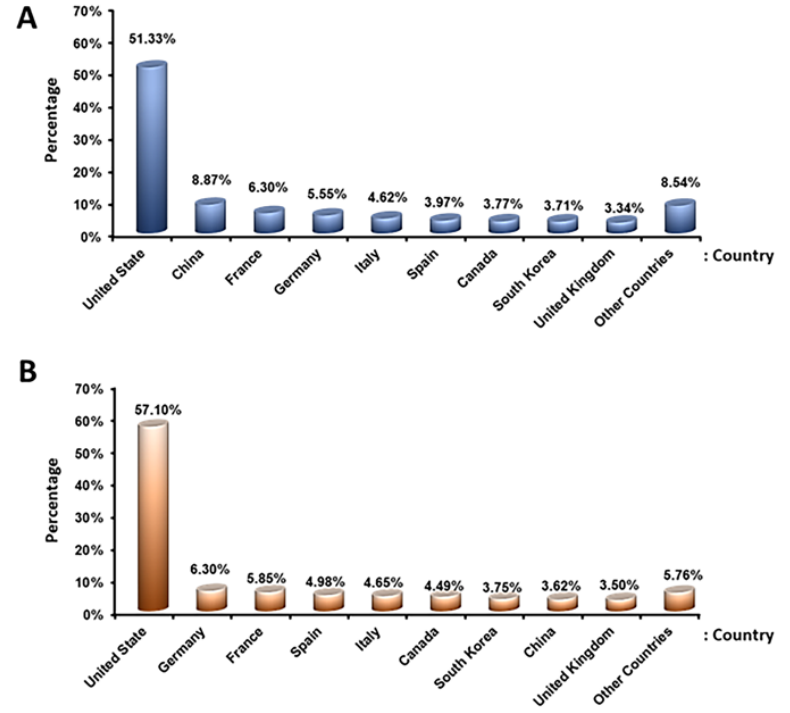
Figure 9. The registered and completed clinical trial studies using stem cells according to participating countries: ( A ) top 10 participating countries with registered clinical trials using stem cells; and ( B ) top 10 countries based on the completion of registered clinical trials using stem